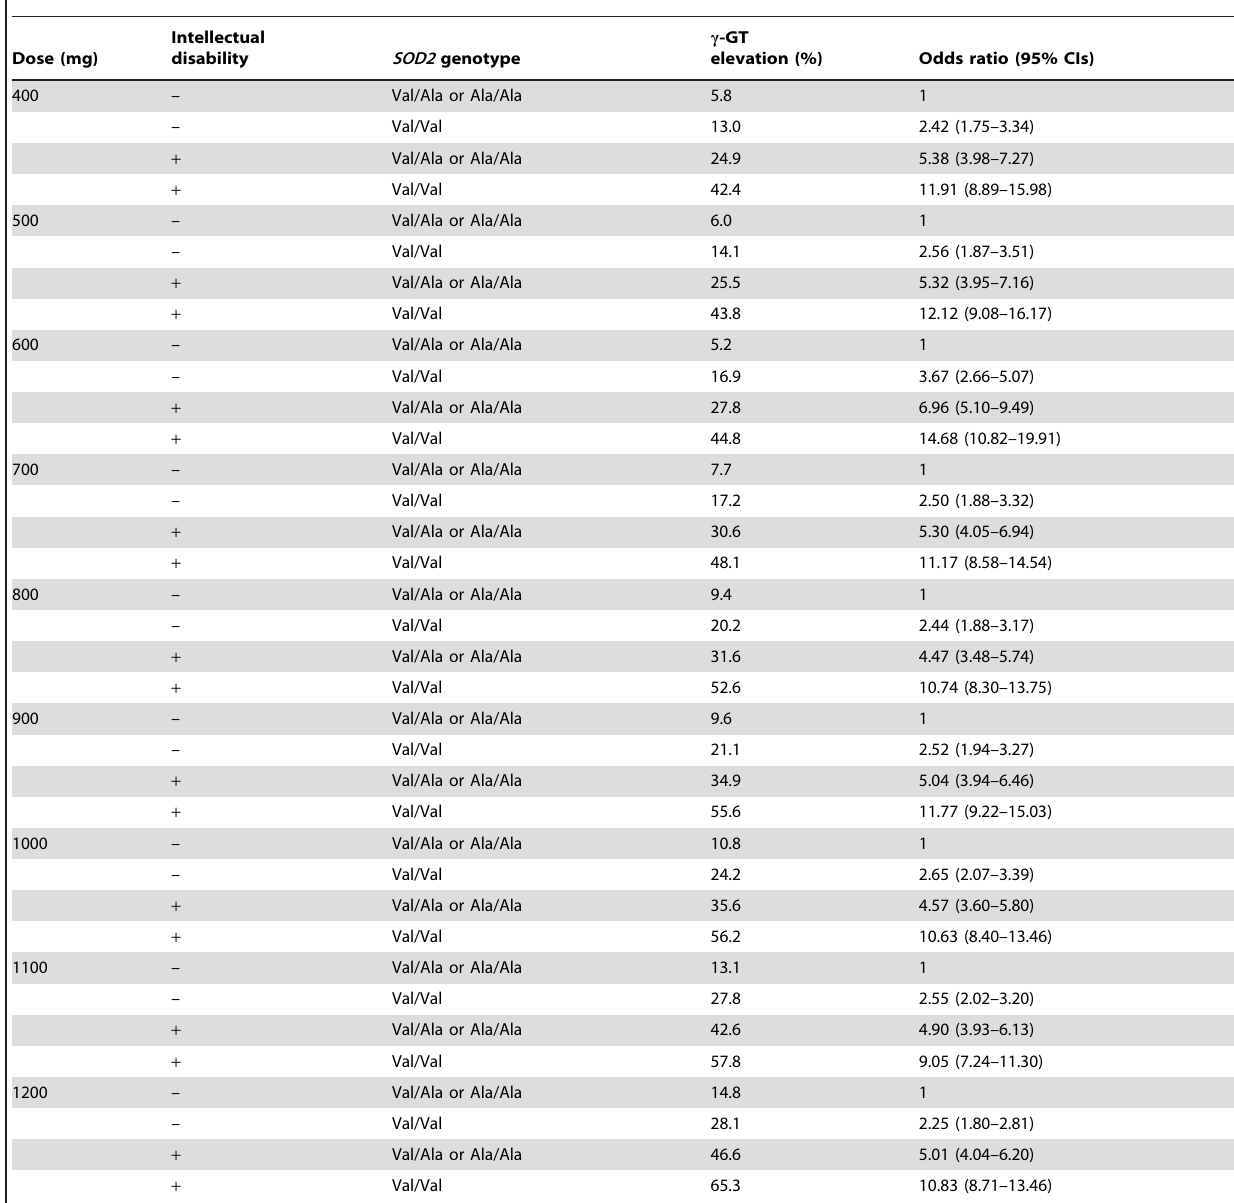
Table 4. The predicted mean percentages of the subjects with c -GT elevation and the mean odds ratios (95% CIs) for c -GT elevation during VPA therapy according to the SOD2 Val16Ala genotype and complication with intellectual disability when different daily doses of VPA were administered to patients without any